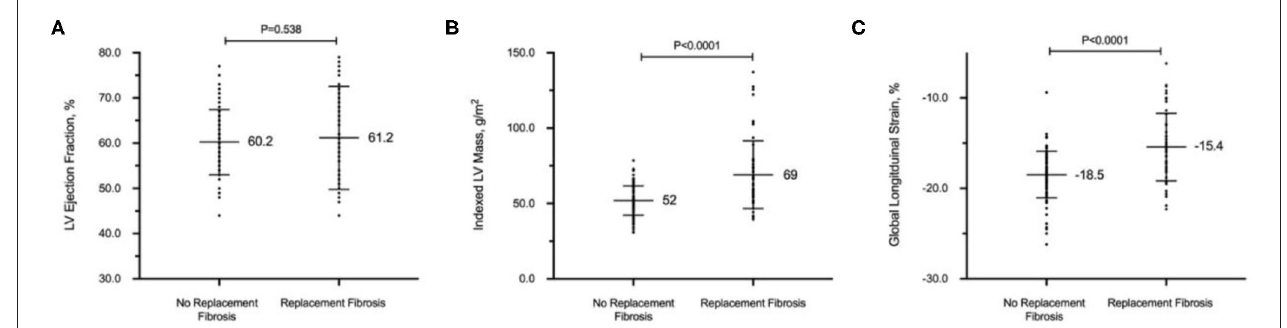
FIGURE 1 | Replacement myocardial fibrosis on cardiovascular magnetic resonance in patients with hypertension. Despite similar left ventricular (LV) ejection fraction (A) , patients with replacement myocardial fibrosis had increased indexed LV mass (B) and worse global longitudinal strain on echocardiography (C) . All values in mean and standard deviation.